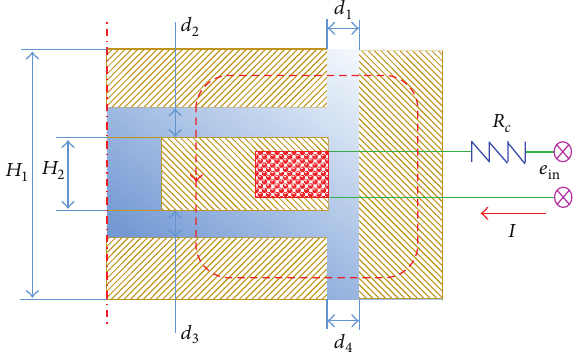
Figure 29: Magnetic circuit of the flexible-valve